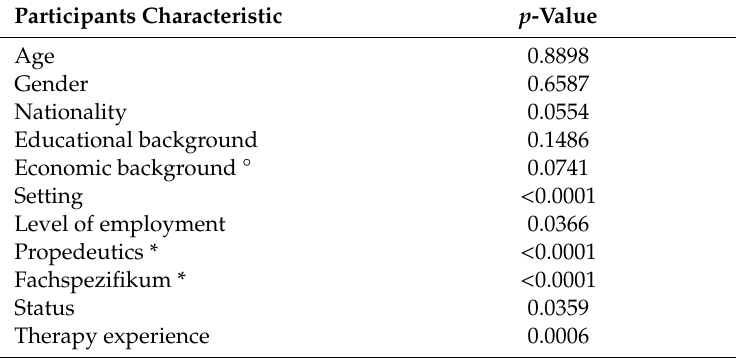
Table 3. Reflective functioning: confronting RF scores with participants characteristics.